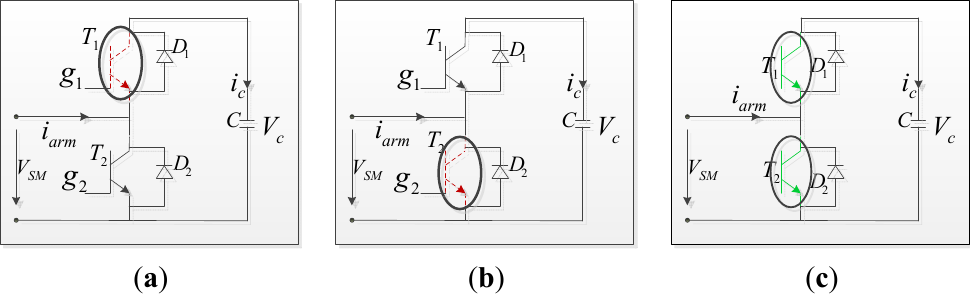
Figure 3. Failure configurations of the modules. ( a ) open-circuit fault in upper IGBT; ( b ) open-circuit fault in lower IGBT; ( c ) short-circuit fault in upper or lower